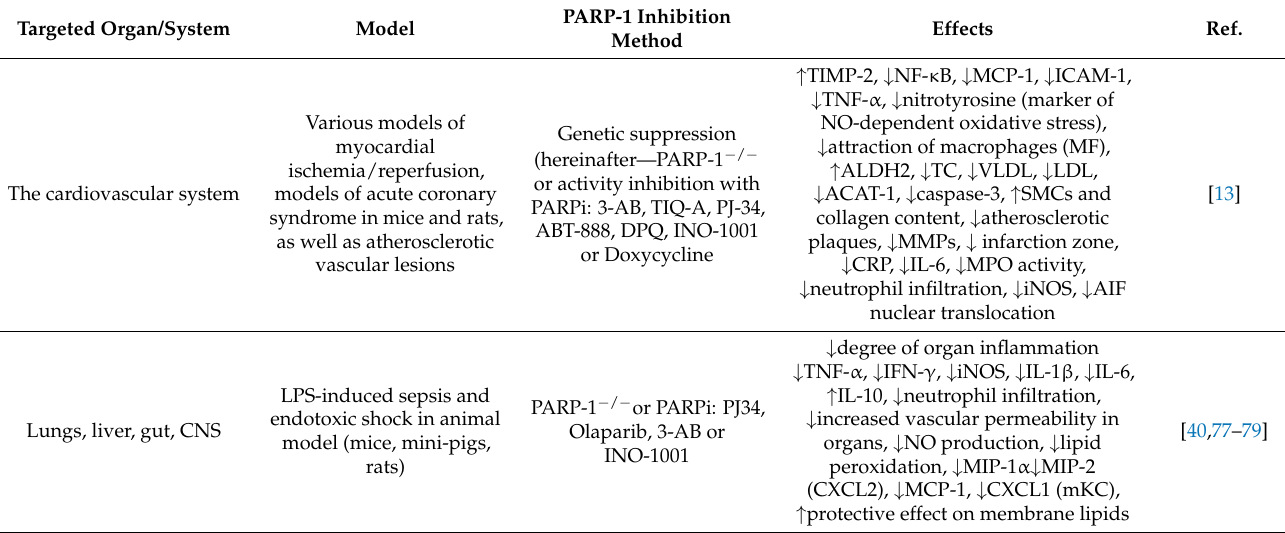
Table 1. Inhibition of PARP-1 in the treatment of non-cancer